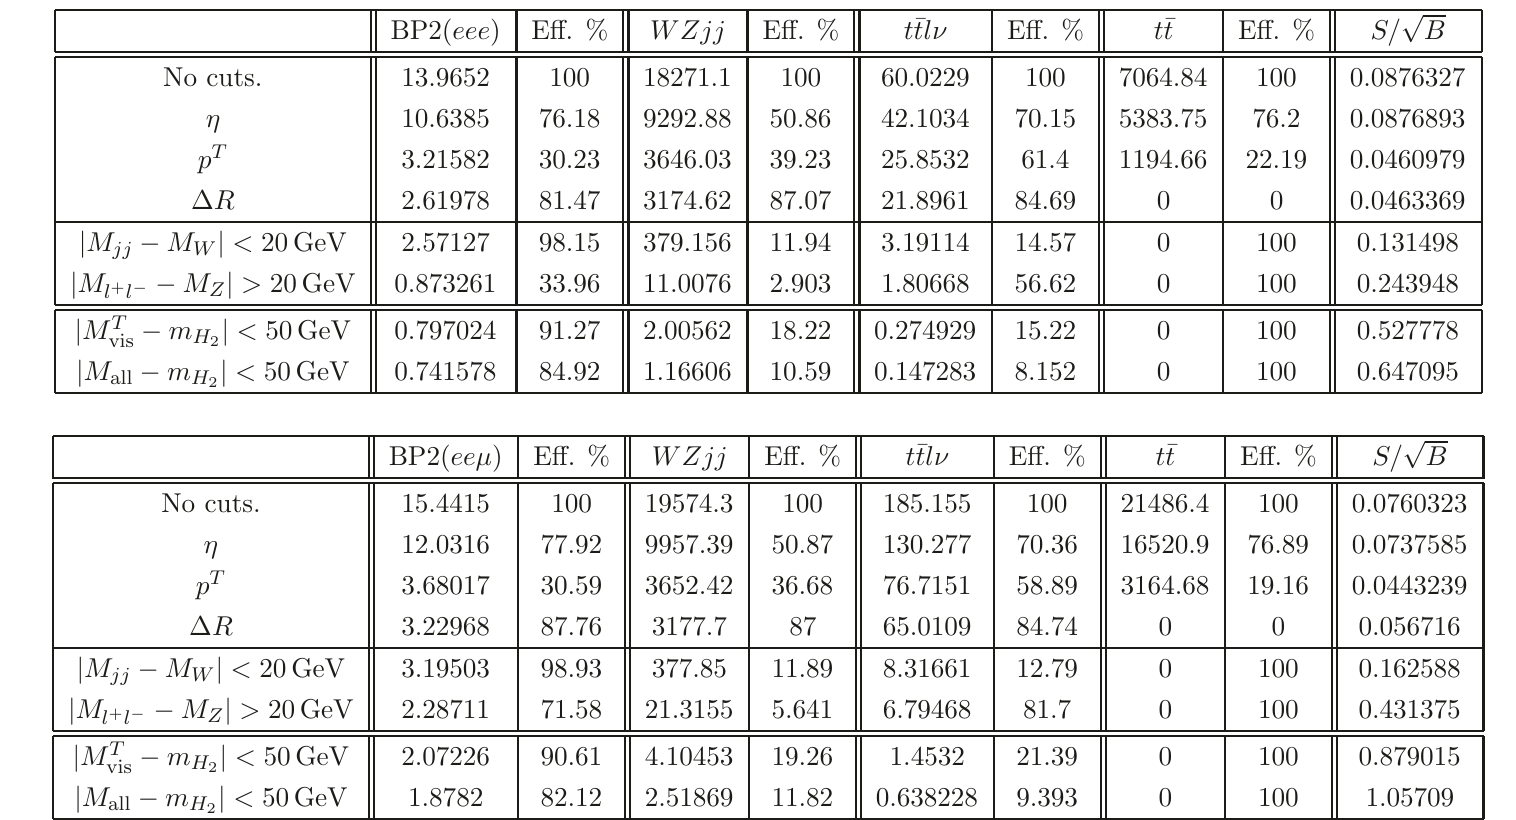
Table 4 . Benchmark point BP2. Luminosity ∆ R lj > 0 . 4 + ∆ R ll > 0 . 3. Transverse momentum cuts for the eee category: p T eeµ category: p T